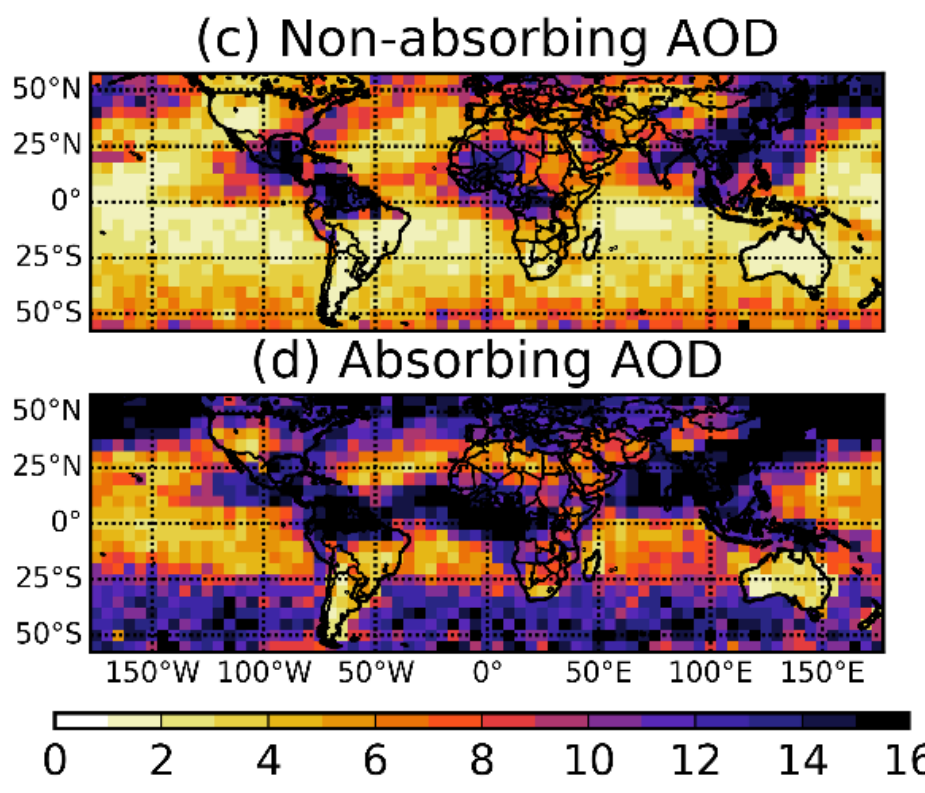
Figure A4. The minimum record lengths required to obtain stable seasonal climatology of ( a ) total, ( b ) nonspherical, ( c ) nonabsorbing, and ( d ) absorbing aerosol optical depths in Spring (March-April-May) within the predefined accuracy levels ( ± 0.01 AOD for ( a ), ± 0.004 for ( b ), and ± 0.005 for ( c ) and ( d )).